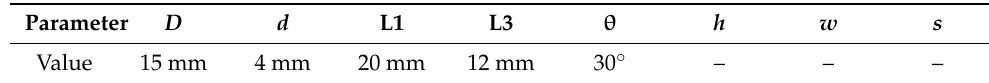
Table 1. Structural parameters of the